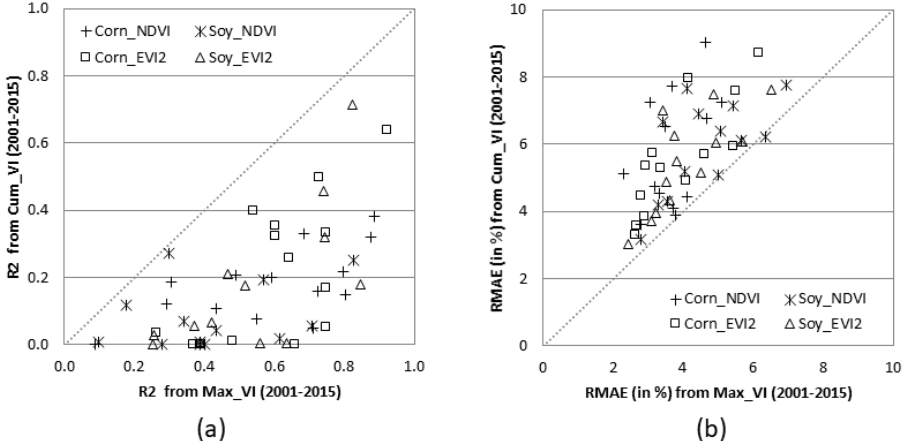
Figure 10. Comparison of R 2 ( a ) and RMAE ( b ) from the small cumulative VIs (NDVI and EVI2) during the period between day 150–300, and the maximum VIs for corn and soybeans from 2001–2015. Each point shows statistics for one year (2001–2015) from 20 counties. Statistics that are not significant ( p -value < 0.05) from both Max_VI and Cum_VI are excluded.